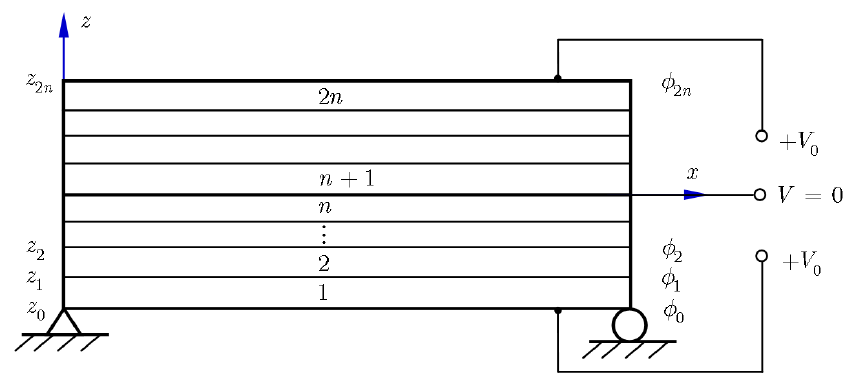
Figure 4. A sublayer model for a piezoelectric